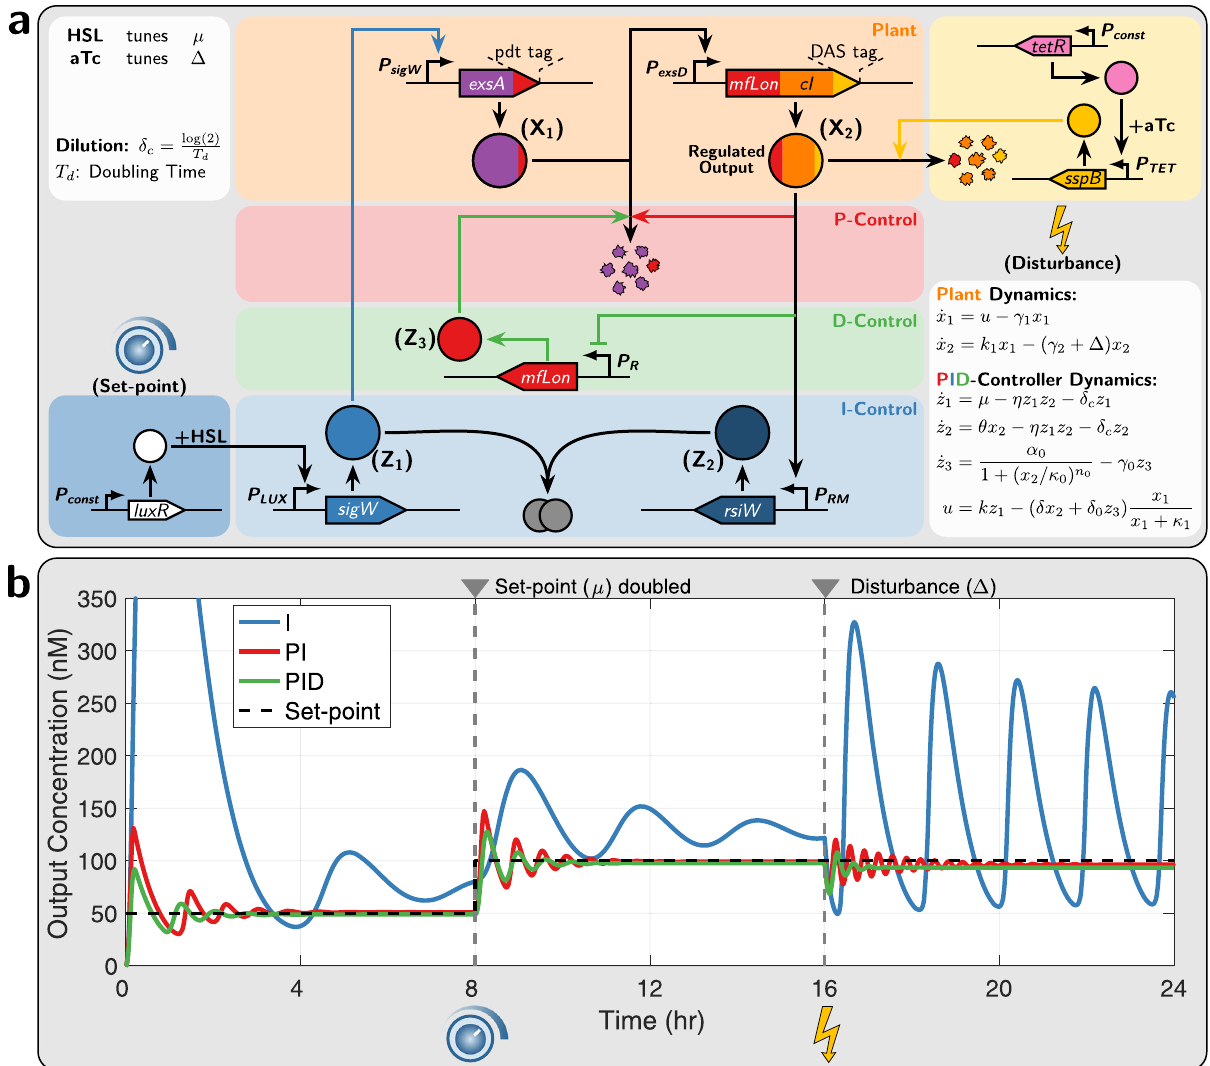
Fig. 8 A genetic implementation of the third-order a PID controller. a Circuit design. The genetic closed-loop circuit is comprised of the plant (in orange) involving two species X 1 and X 2 , the a PID controller involving Z 1 , Z 2 and Z 3 and the disturbance network (in yellow). The objective is to force the regulated output X 2 to track a tunable setpoint, despite the injected disturbance, and enhance the transient dynamic response. The antithetic integral control is implemented via the sequestration between the σ factor (SigW denoted by Z 1 ) and anti- σ factor (RsiW denoted by Z 2 ) 9 that are driven by the promoters P LUX and P RM 52 , respectively. The setpoint is encrypted in the expression rate μ of Z 1 that is tunable with homoserine lactone (HSL). The plant is comprised of two genes. The fi rst gene encodes exsA 62 fused to the degradation pdt tag (recognized by M fl on), and is driven by a SigW-responsive promoter P sigW . The second gene is driven by the ExsA-responsive promoter P exsD 62 and encodes the protease MfLon and the transcription factor cI fused to the ssrA(DAS) degradation tag. The disturbance circuit (in yellow) increases the degradation rate of X 2 by expressing sspB at a tunable rate, with anhydrotetracycline (aTc), which in turn recognizes the DAS tag in X 2 and sends it to the endogenous degradation machinery 63 . The MfLon in the output X 2 is capable of degrading the input X 1 , while the dual activator/repressor cI is capable of activating P RM and repressing P R 52 . The promoter P RM drives the integral control module, while P R drives another gene that expresses MfLon denoted by the control species Z 3 that is also capable of degrading the input X 1 . Note that the protease MfLon encoded in X 2 and Z 3 implements an incoherent feedforward loop connected in feedback with the plant and thus realizing a PD-controller. b Deterministic simulations. Simulation of the closed-loop dynamics with I, PI, and PID control. The plot shows the dynamic response of the regulated output X 2 to a step change in the setpoint at t = 8 h and to a disturbance injection at t = 16 h. The simulations are carried out using biologically realistic numerical values for the various parameters (see Supplementary Information Section fl uorescence measurement. Multiple cells can be targeted and should be stimulated with. The light intensity data, once com- observed individually in parallel on this platform. Under the puted for every target cell in the microscope fi eld of view, are sent cyberloop framework, at fi rst, individual cellular outputs are to a specialized custom-built projection hardware 54 that then stimulates target cells with their corresponding light intensities in observed and quanti fi ed via fl uorescence imaging and subsequent a parallel fashion, thus closing the control loop. This fl uorescence image processing. The quanti fi ed value for each cell is then fed to measurement and subsequent light stimulation steps are repeated a stochastic simulation 55 of controller reactions (one controller every fi xed interval providing us with single-cell time-course data simulation per cell) that computes the light intensity (based on for the controller performance and output behavior. the controller species abundance) which the corresponding cell